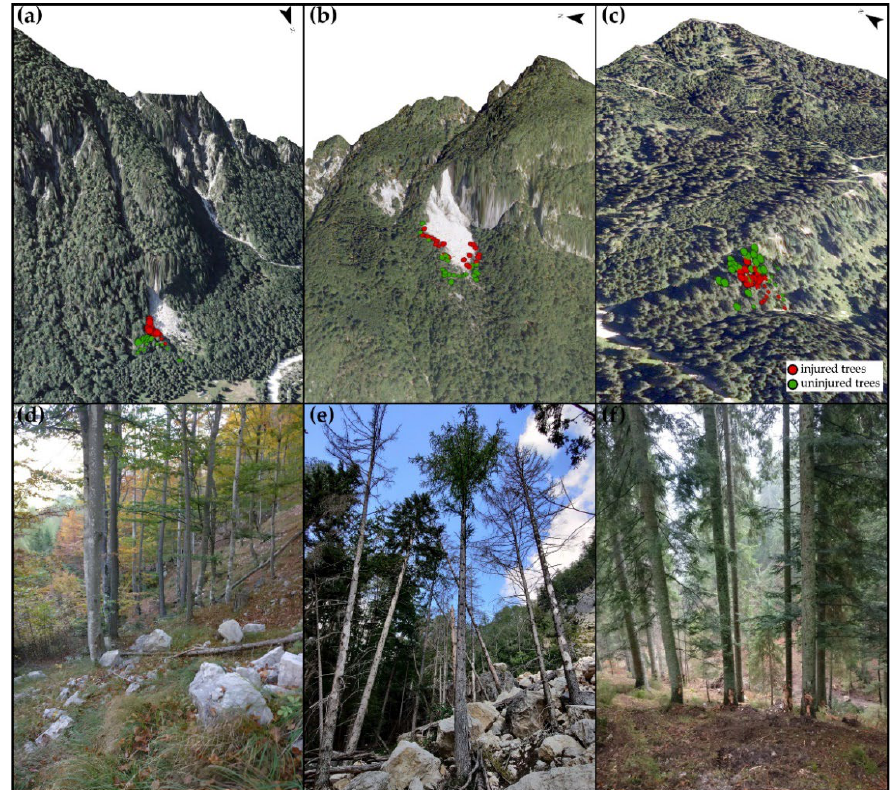
Figure 2. Three-dimensional visualization of the study sites including pictures from the field: ( a , d ) Kekec, ( b , e ) Cerkev, and ( c , f ) Jelovica.